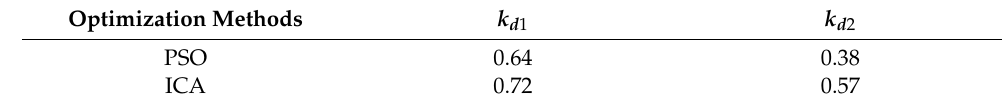
Table 4. The values of coefficients k d1 , and k d2 .